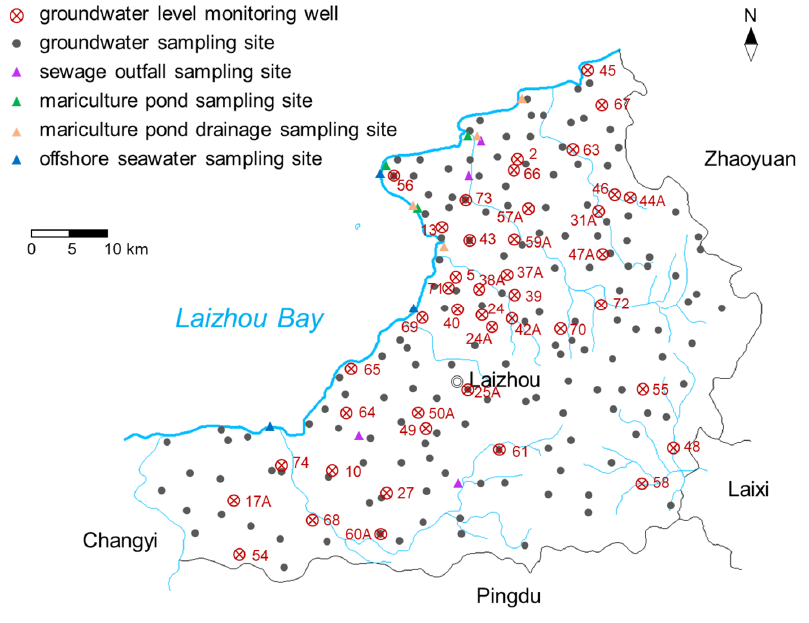
Figure 5. Location map of surface water and groundwater sampling sites.